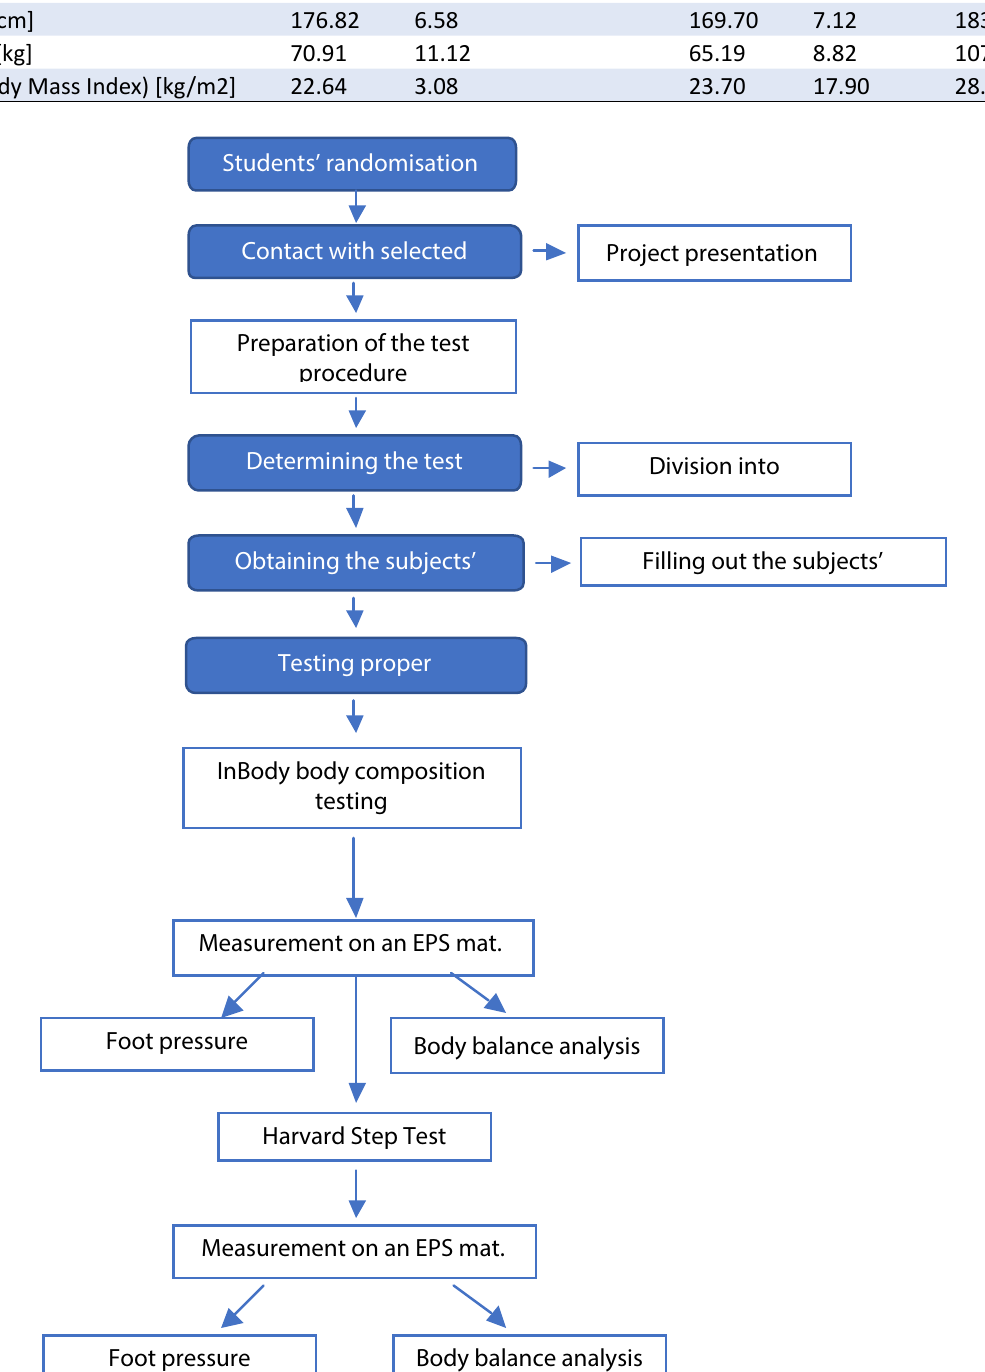
Fig. 1. Diagram of the test procedure